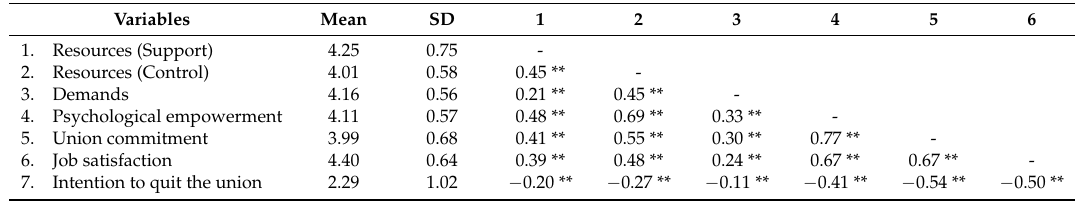
Table 1. Correlations, means, and standard deviations of study